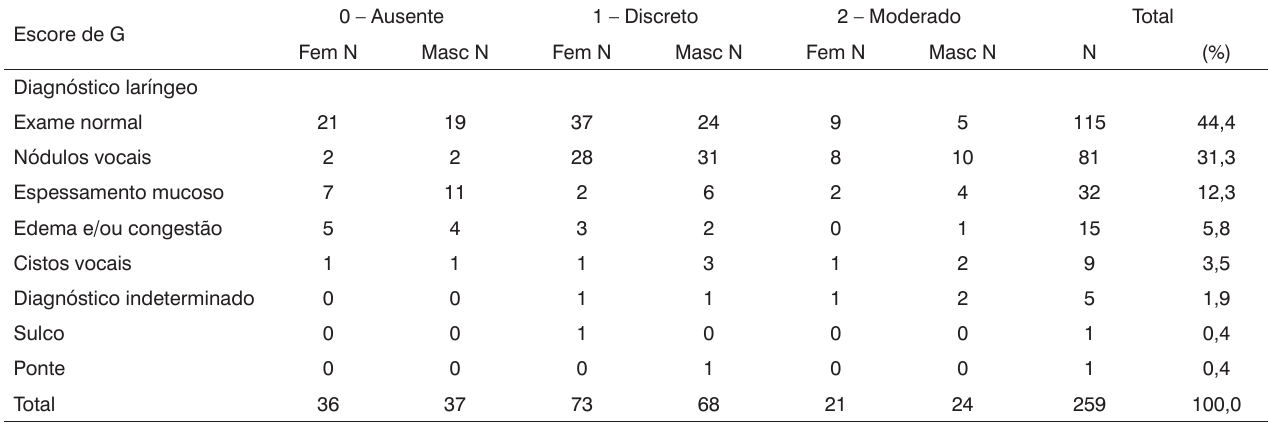
Tabela 13. Resultados dos exames de